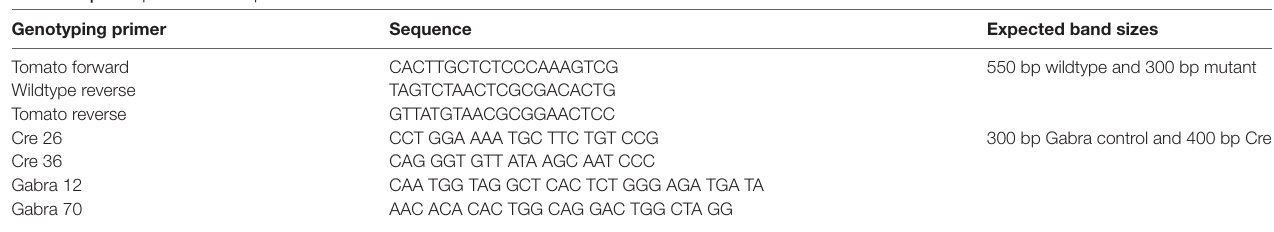
TABLE 1 | PCR primers and expected band